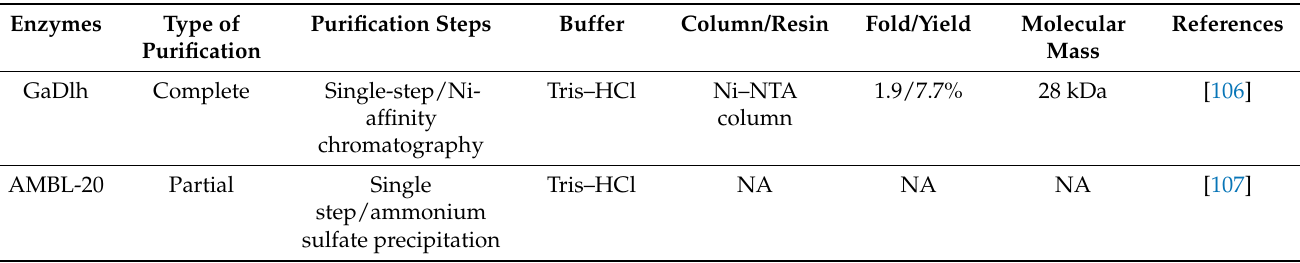
Table 2. Purification of Cold-adapted Esterase and